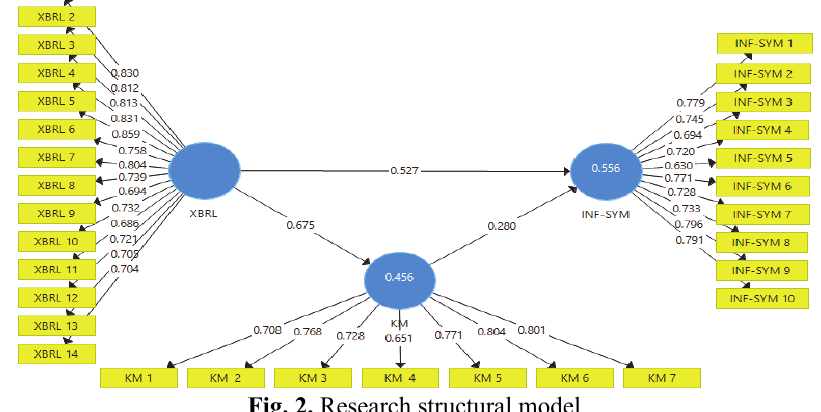
Fig. 2. Research structural